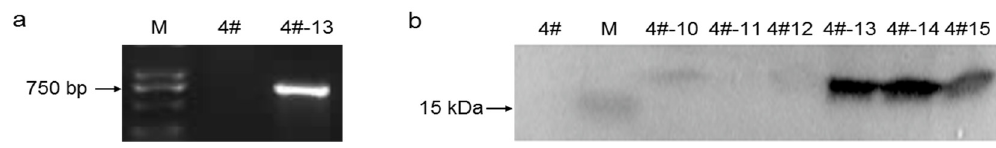
Figure 2. Results of expression of VHb in R. toruloides strains. ( a ) PCR amplification of VHb gene. M, DNA maker. ( b ) Western blot analysis of VHb expression. M. Protein molecular weight marker.